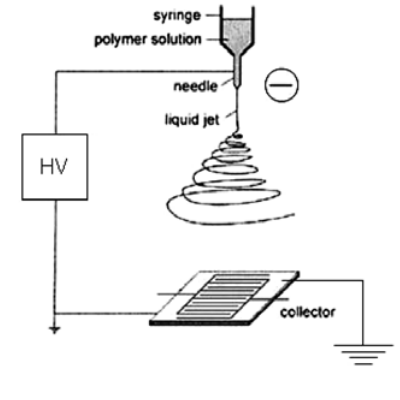
Figure 3. Schematic of the experimental setup for electrospinning synthesis of